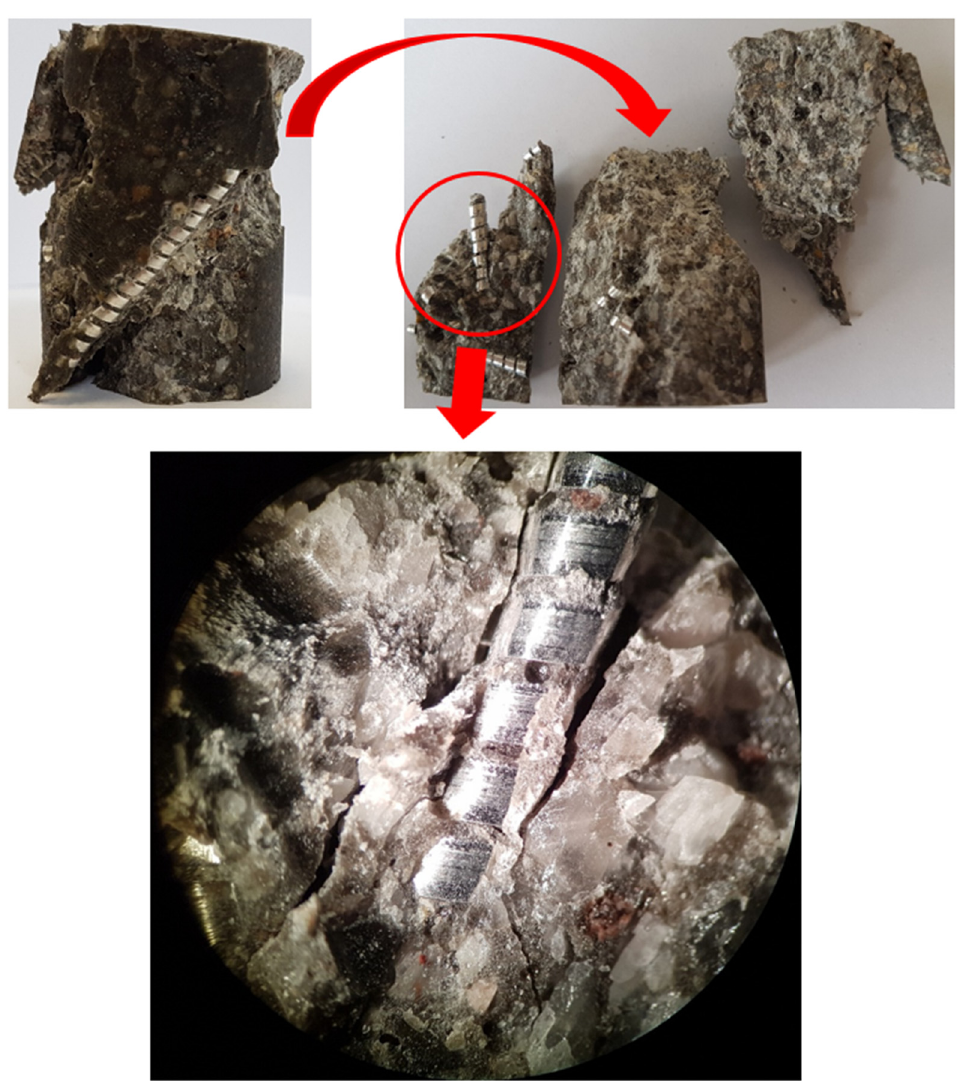
Figure 10: Example of fracture of the specimen after the